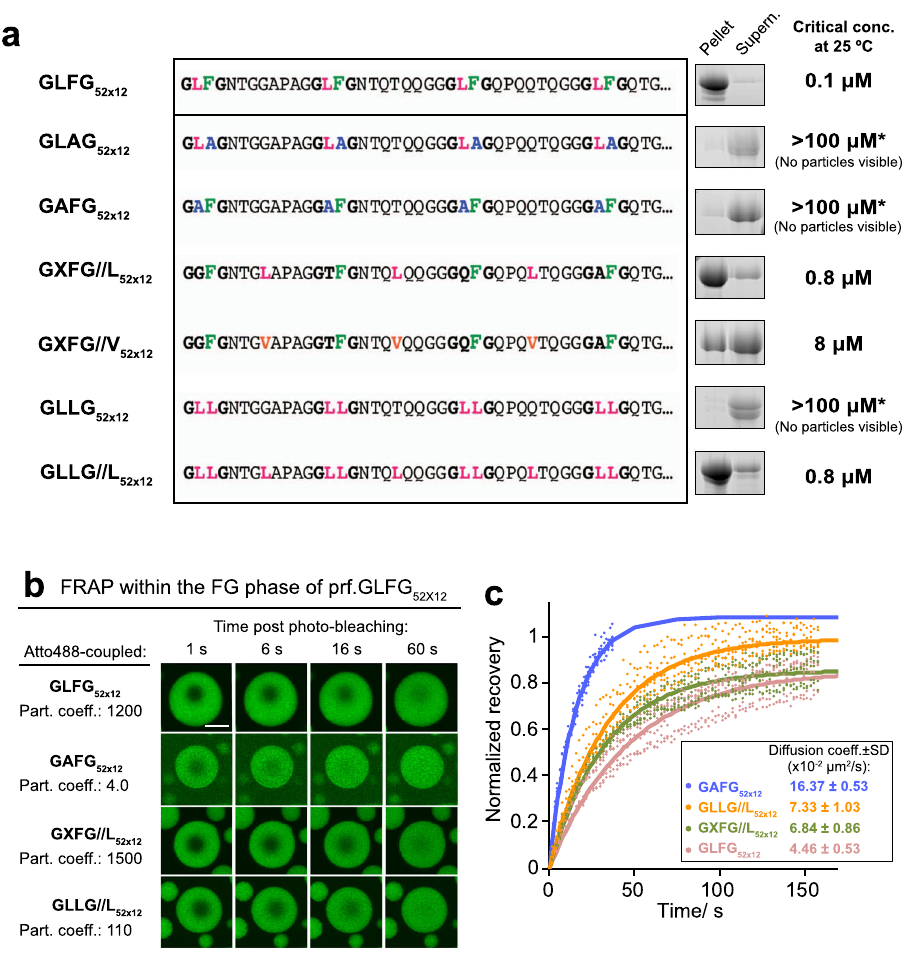
Fig. 7 In fl uence of hydrophobic residues on the phase separation of FG domains. a Critical concentrations for phase separation were determined on a series of GLFG 52×12 variants. GLFG 52×12 is an engineered FG domain variant, which contains 52 GLFG motifs fl anked by non-identical sequences (spacers) of equal length. The spacers do not contain Phe and Leu. ‘ // ’ indicates the swapping of a spacer residue with a residue from the GLFG motif. For a detailed description of the variants, see the main text. For space economy, the N-terminal sequences up to the fourth FG motif are shown, while the C-terminal sequences (~620 residues) follow the same design strategy (see Supplementary Note 1 for complete sequences). Phase separation of the variants were analysed as in Fig. 1d at 25 °C, at [FG domain] = 10 μ M, [NaCl] = 150 mM. *The analyses for GAFG 52×12 , GLLG 52×12 and GLAG 52×12 were repeated at [FG domain] = 100 μ M, and no signi fi cant phase separation was observed (Supplementary Fig. 6). Full scans of gels with molecular weight markers are